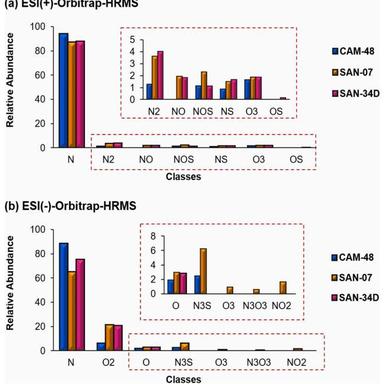
Class diagrams by (a) ESI(+)-Orbitrap-HRMS and (b) ESI(-)-Orbitrap-HRMS.